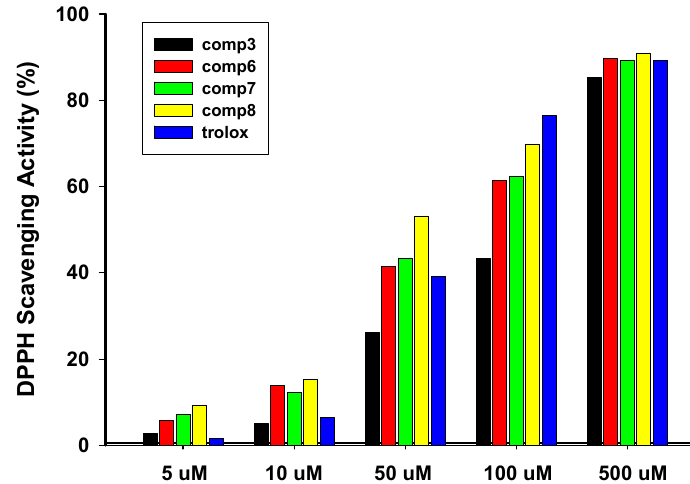
Figure 4. Rate of scavenging 2,2-diphenyl-1-picrylhydrazyl (DPPH) radical of analogues 3 and 6 – 8 .